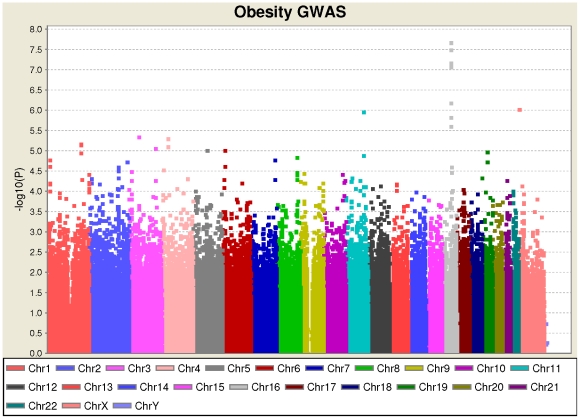
Manhattan plot (logarithm of P-values versus chromosome coordinates) for SNP association on obesity.The FTO locus on 16q12.2 reached genome-wide significance.